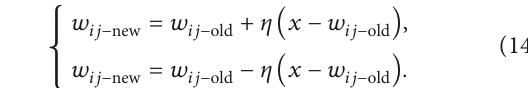
Figure 4: A typical CNN network